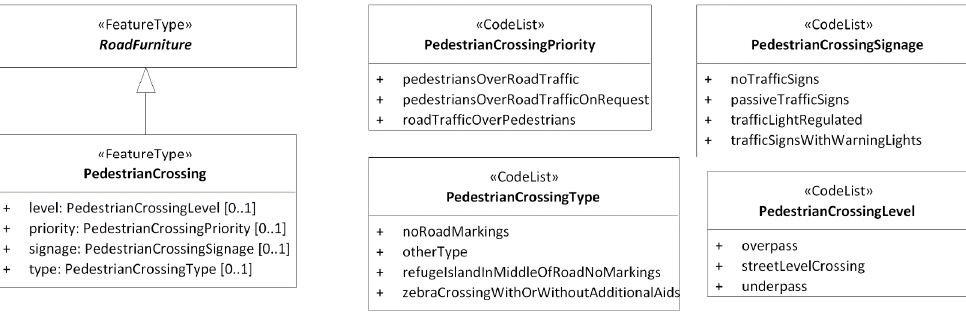
Figure 14. ISO 19109 compliant model of GDF 5.0 PedestrianCrossing.